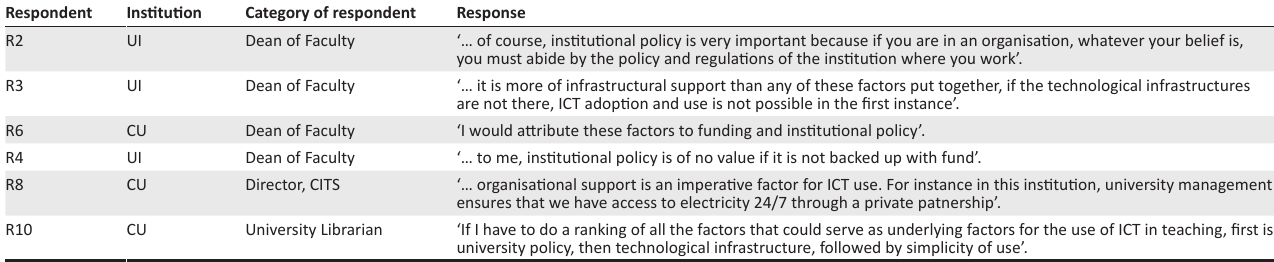
TABLE 4: Synopsis of interview responses on underlying success factors for information and communication technology use ( N = 10).